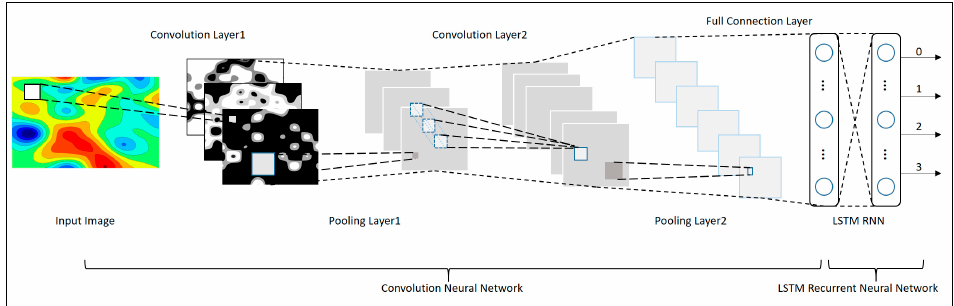
Figure 6. The structure of the hybrid deep neural networks used for emotion classification.